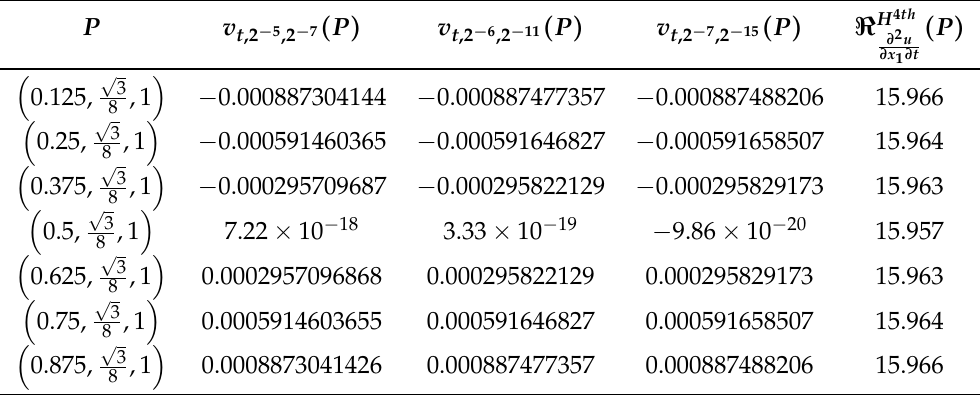
Table 6. The numerical solution v t , h , τ at seven points when t = 1, and the convergence orders ) for the Example 2. obtained by H 4 th ( ∂ 2 u ∂ x 1 ∂ t